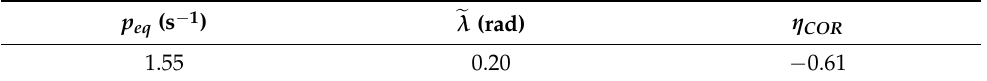
Table 4. Masonry wall with openings. Equivalent rocking parameters calculated by the GhPython script.